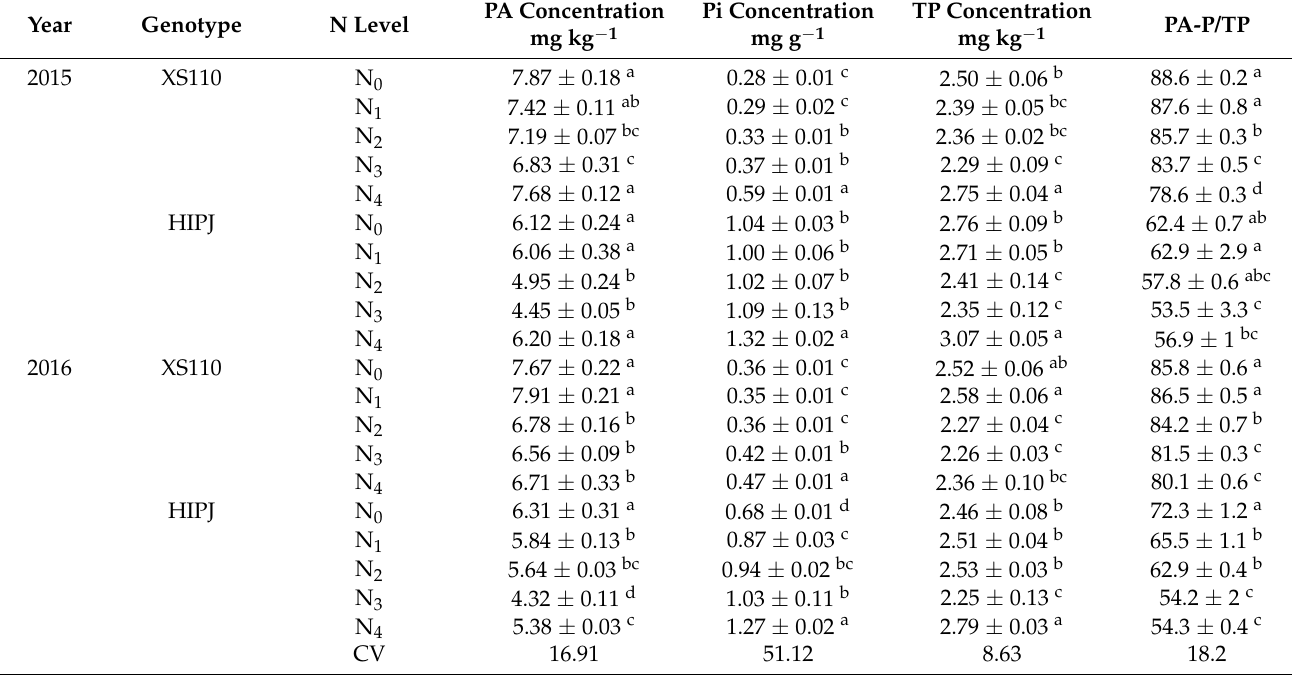
Table 4. Effect of N levels on grain P components (phytic acid, inorganic phosphorus, total phospho- rus, and PA-P/TP) in the detached panicle culture